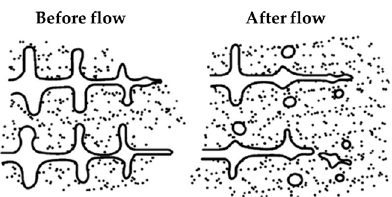
Figure 3. Schematic model of dendrite arms remelting [4].